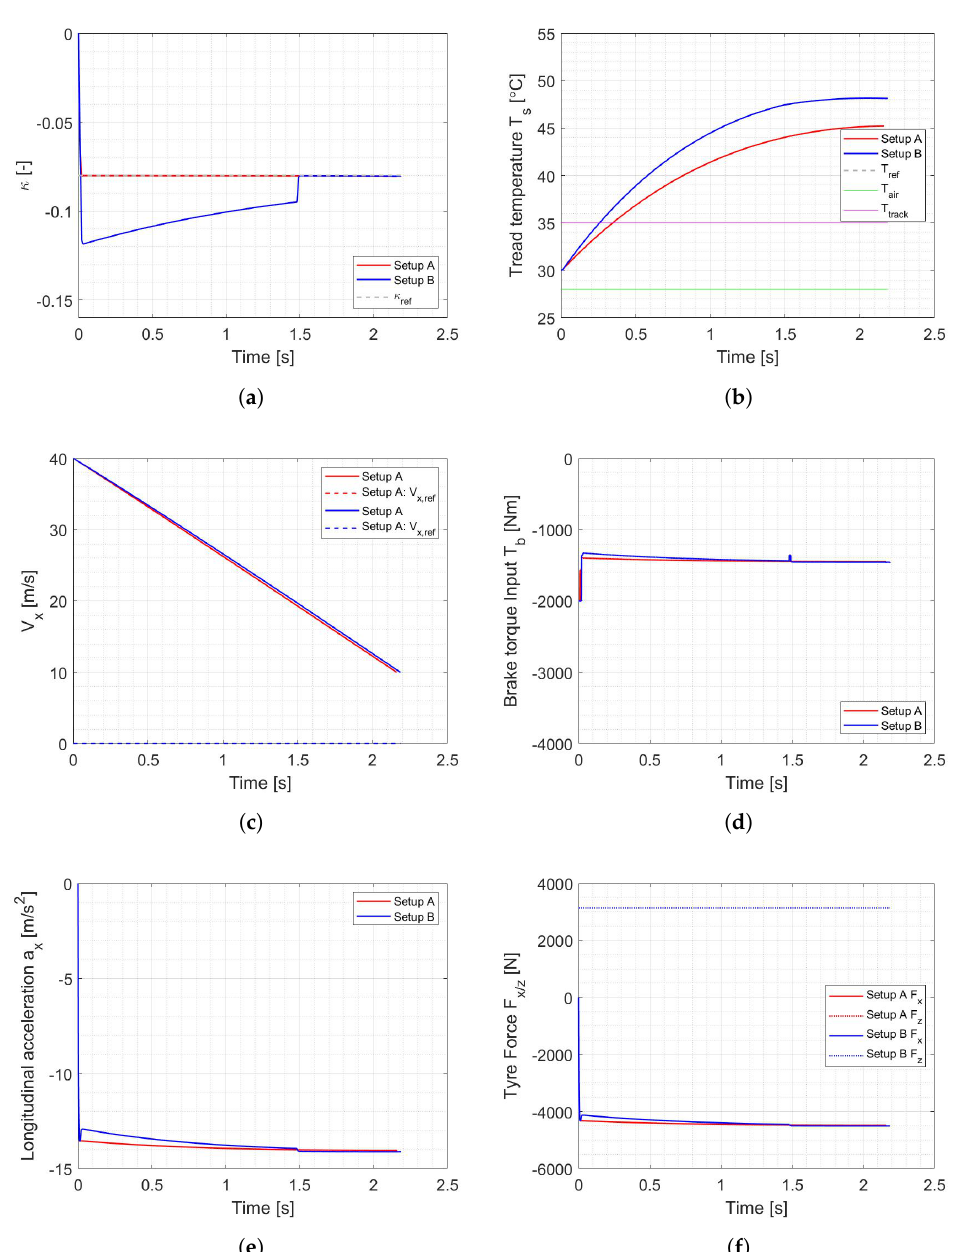
Figure 18. Time histories of variables and control inputs for all the setups (A and B) of quarter-car NMPC ABS controller with T a = 28 ◦ C and T t = 35 ◦ C, starting at 40 m/s. ( a ) Longitudinal slip κ . ( b ) Tread temperatures T s . ( c ) Vehicle longitudinal velocity V x . ( d ) Brake torque control input T b . ( e ) Vehicle longitudinal acceleration. ( f ) Longitudinal force F x and vertical load F z